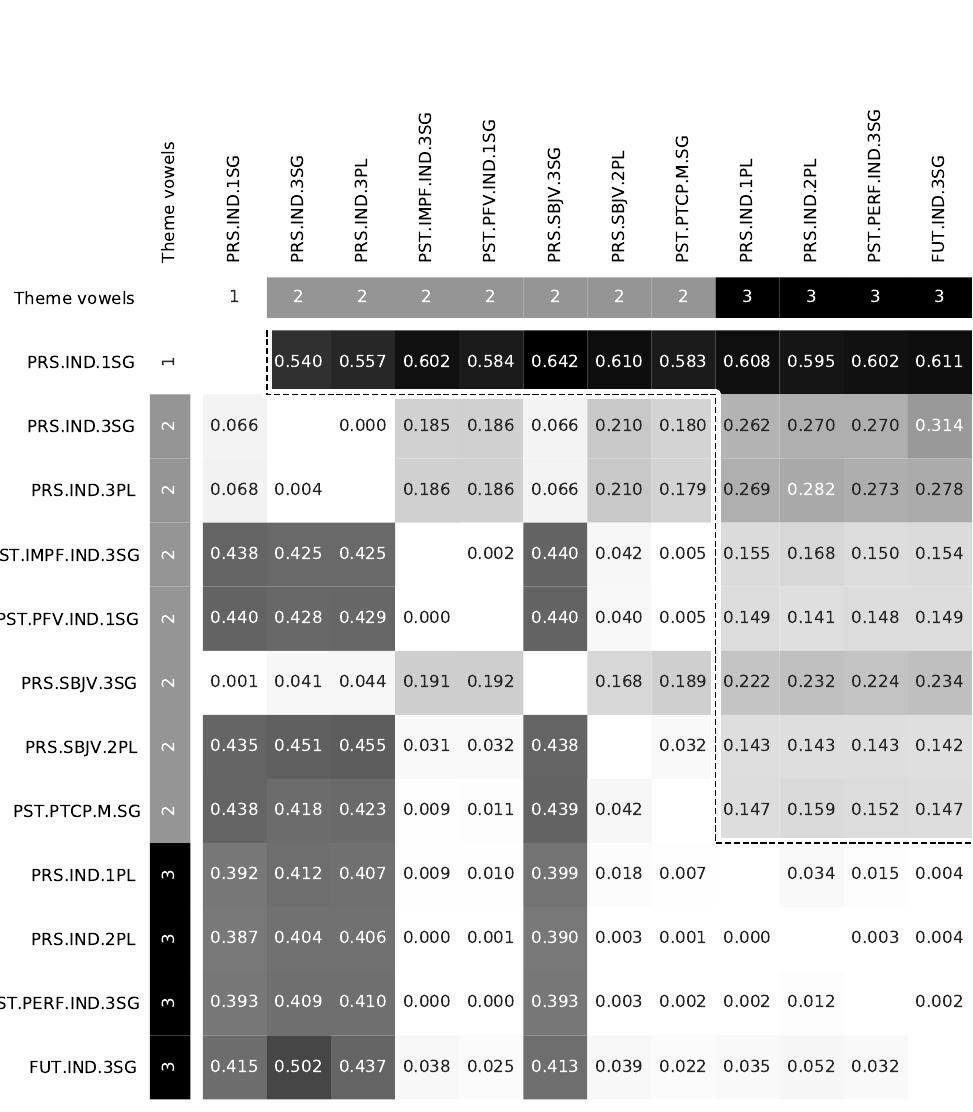
Figure 3: The influence of theme vowel distinctions on conditional